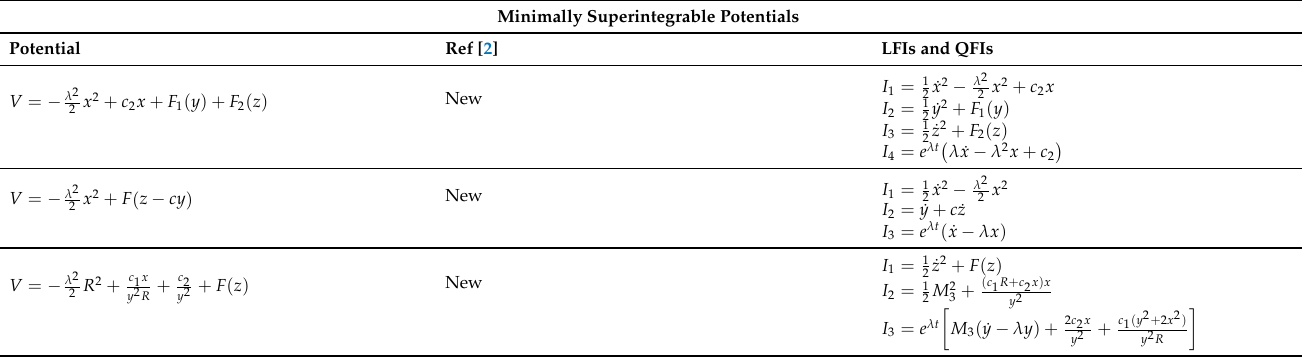
Table 12. Minimally superintegrable potentials V ( x , y , z ) in E 3 that admit time-dependent LFIs/QFIs of the form I ( 3 )